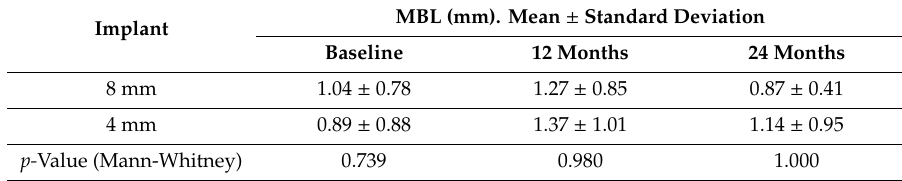
Table 4. Mean MBL (marginal bone loss) values (mm) ± standard deviation by implant type at each evaluation time.